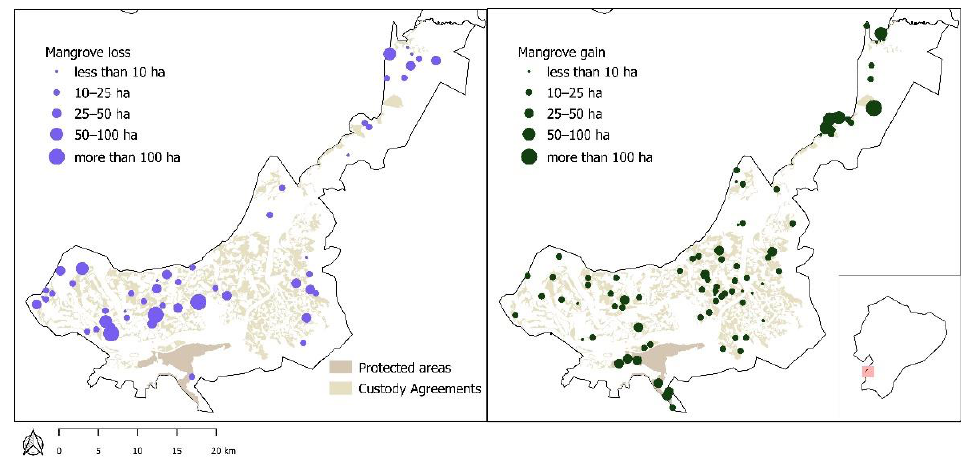
Figure 9. Mangrove losses and gains in the Guayas province between 1984 and 2016.